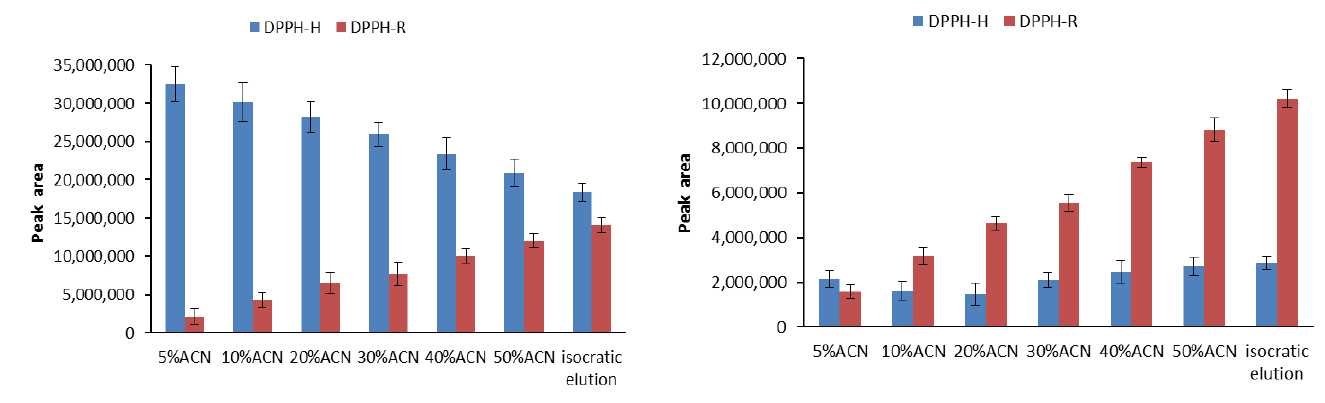
Figure 2. Comparison of the DPPH-R (red) and DPPH-H (blue) peak areas obtained using isocratic elution mode with 60%ACN, as well as gradient modes starting with 5%ACN, 10%ACN, 30%ACN, 40%ACN, and 50%ACN. The chromatograms were monitored at 330 nm ( a ) and 517 nm ( b ). The error bars indicating SD were calculated on the basis of three independent measurements.